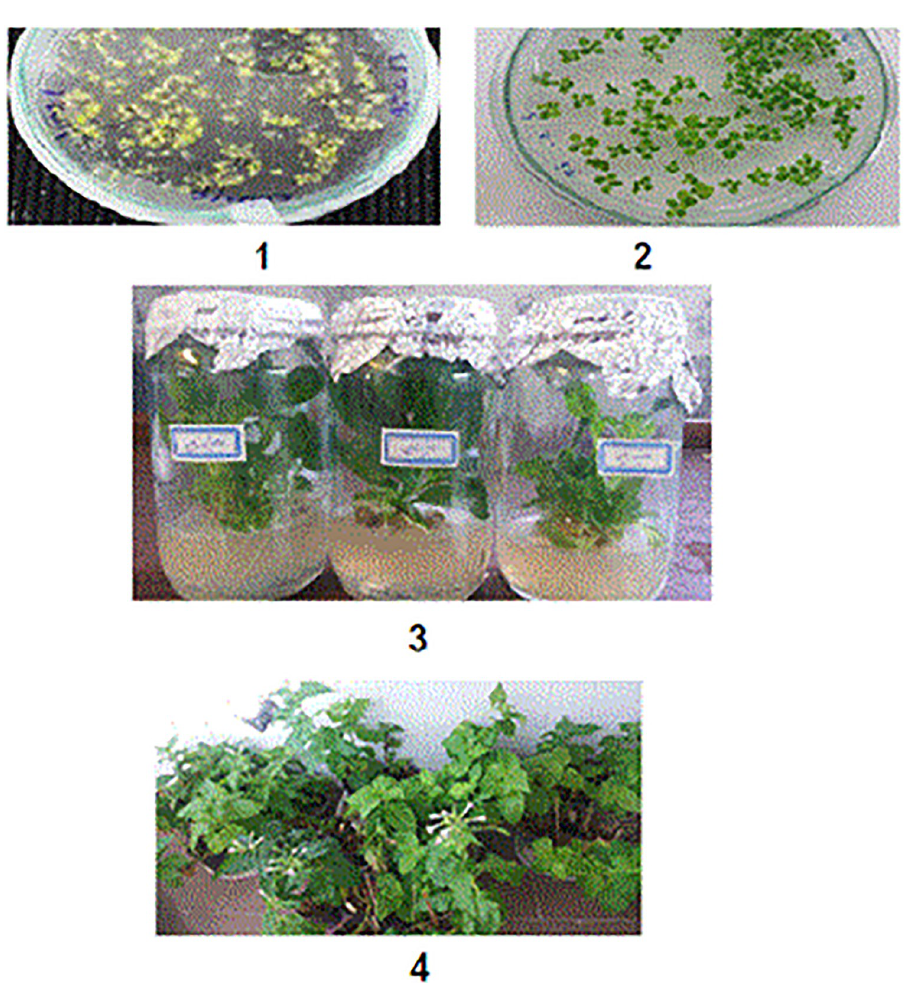
Fig 2. Stages of cultivation of T2 seeds in Kanamycin and growth of third generation transgenic plants (T2): 1) Seeds of second generation transgenic plants (T1) (2), Seeds of non-transgenic plants (3). Transgenic seedlings transferred to culture medium 4) Growing of transgenic tobacco plants (T2) in pots and starting the seed production stage for the fourth generation.